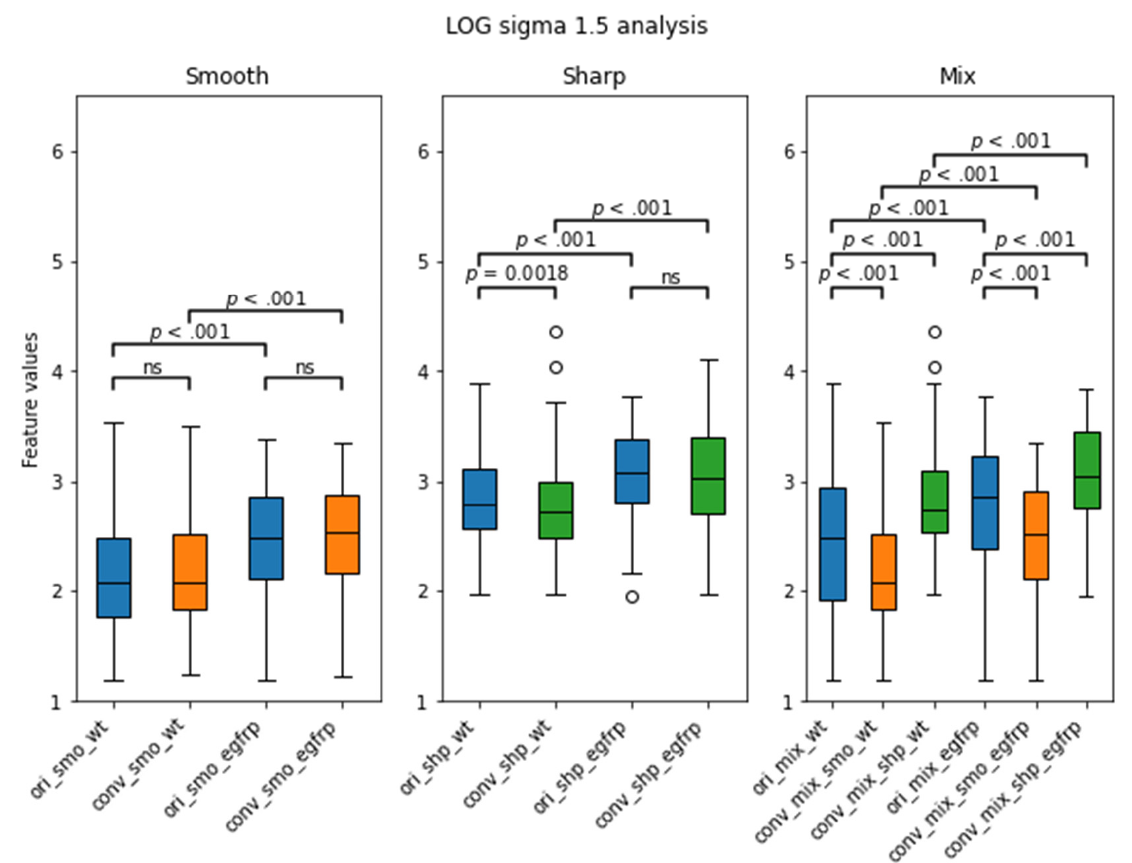
Figure 6. LOG sigma 1.5 feature’s distribution boxplot analysis from the validation cohort separated by EGFR status. WT stands for wildtype, and egfrp stands for EGFR positive. There were significant differences between the WT and the EGFR subgroups in all kernels. Notably, there was no significance between the original smooth subgroups and their converted smooth counterparts. p value less than 0.01 was considered to be significant. ns = not significant.